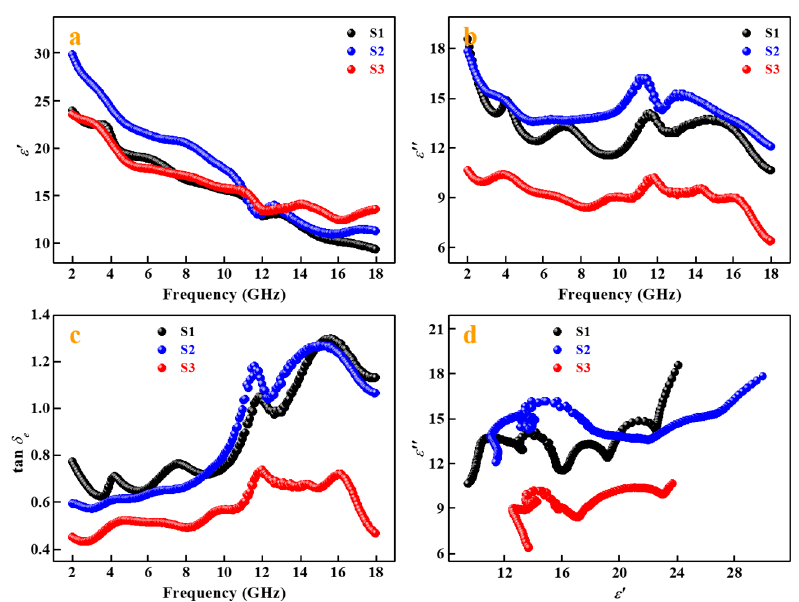
Figure 8. Frequency dependence of ( a ) the real part ( ε ’) and ( b ) imaginary part ( ε ”) of complex permittivity, and ( c ) dielectric loss (tan δ e ) and ( d ) Cole–Cole curves for as-prepared composites with different PIP cycle numbers in the frequency range of 2–18 GHz.